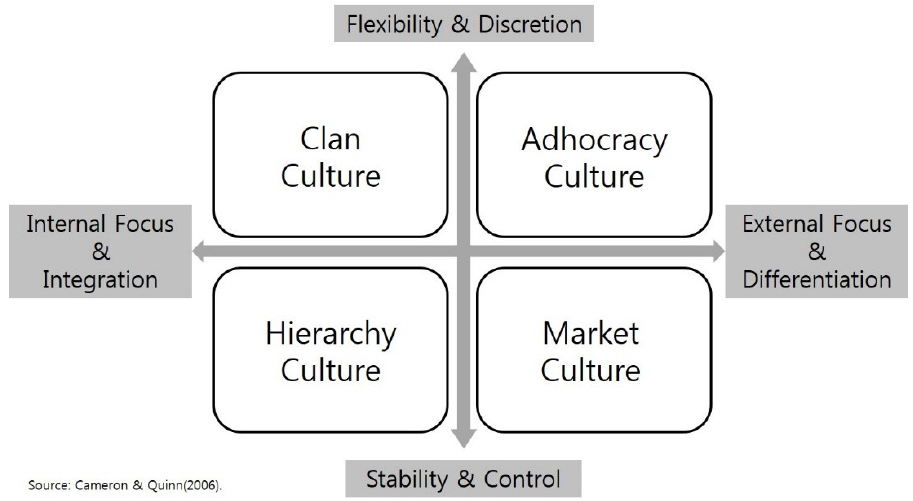
Figure 1. Competing Values Framework.